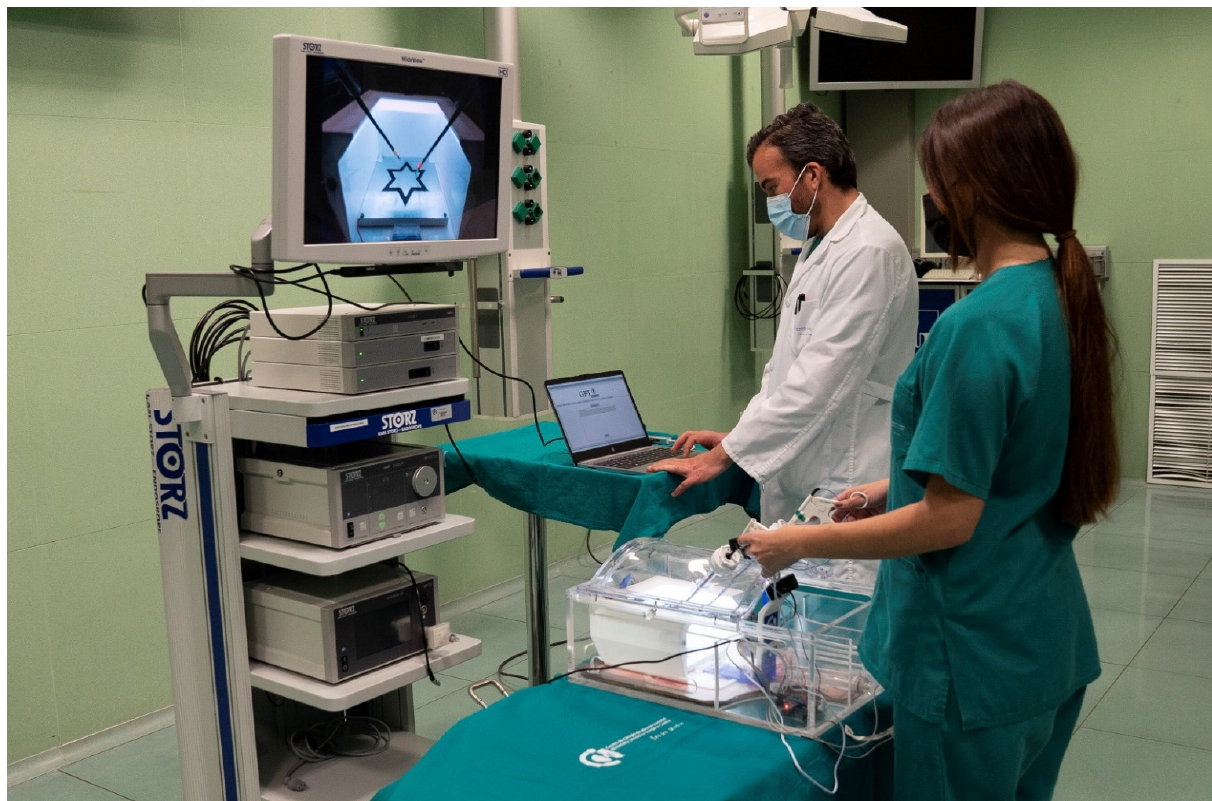
Figure 3. Setup of the experiment. ECG and GSR sensors are located inside the box trainer (red light). Eye tracker located immediately below the monitor showing the video feed captured by the camera inside the box trainer. The laptop is running the application gathering data. Research